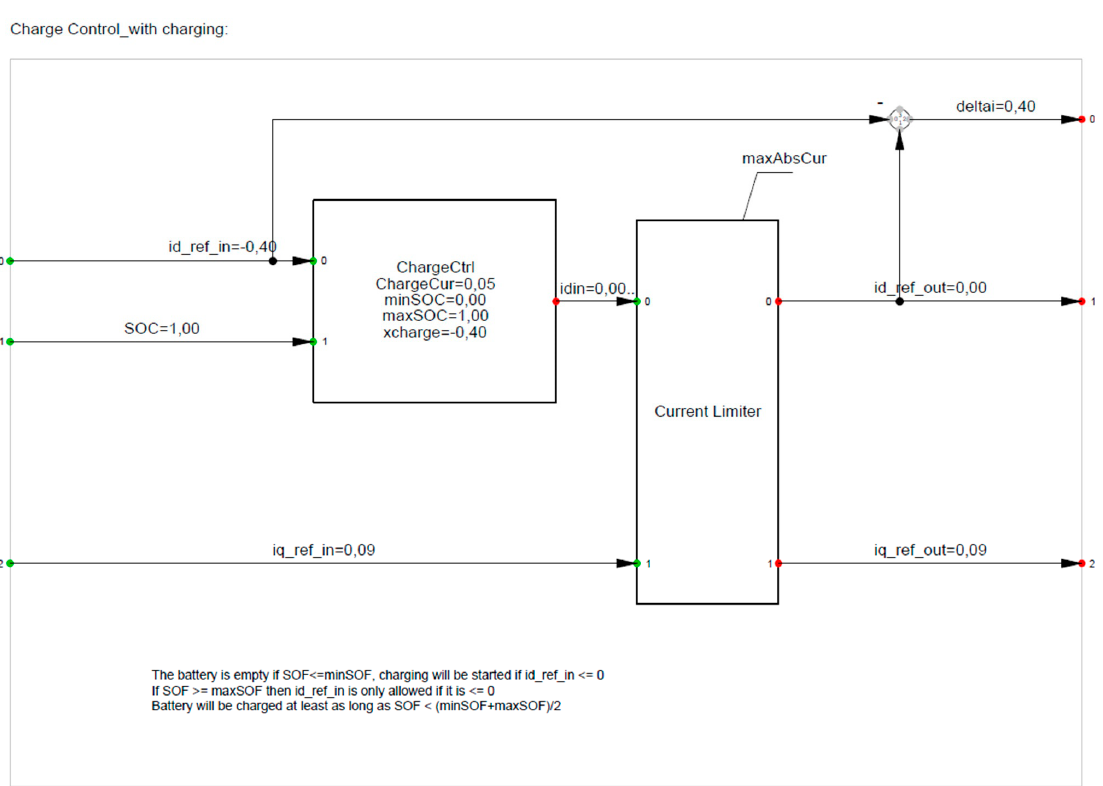
Figure 4. Model of charge–discharge regulator.